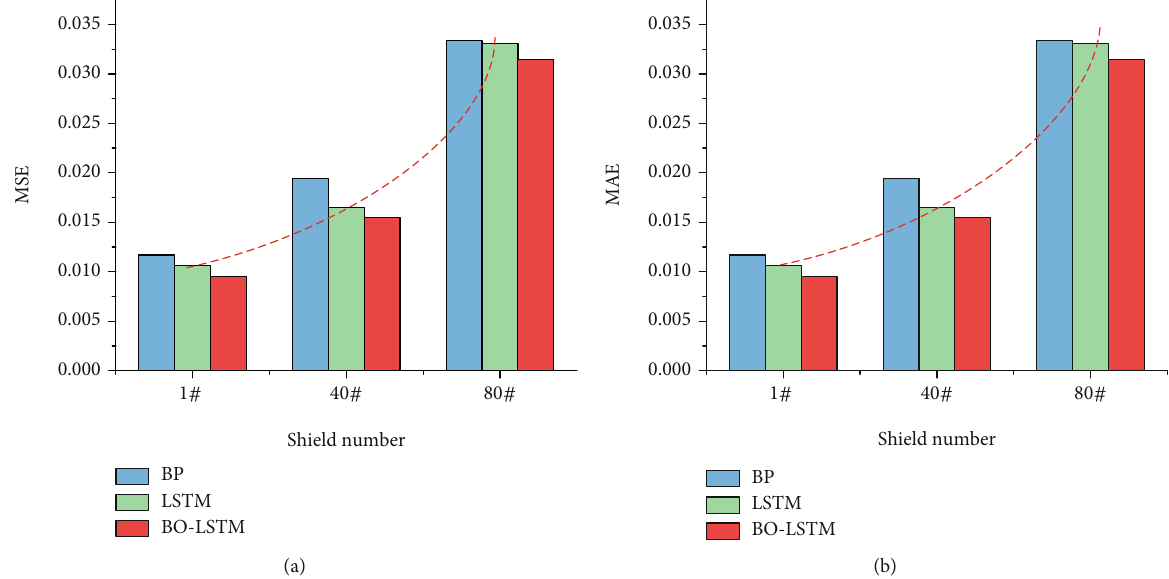
Figure 13: Comparison among errors by the BP, LSTM, and BO-LSTM